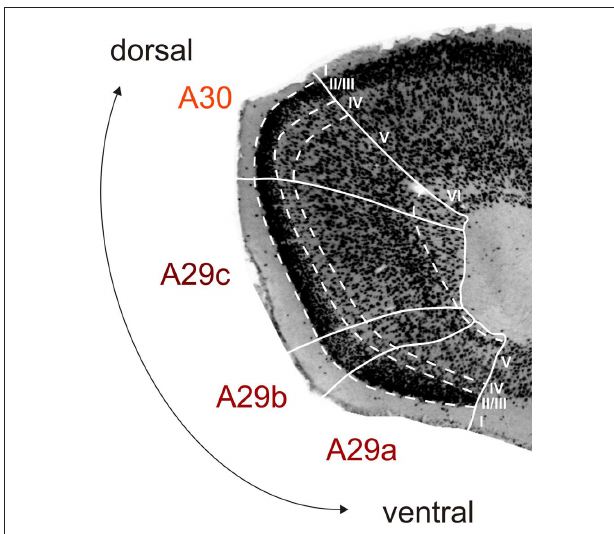
Figure 2 | Cytoarchitecture of rat retrosplenial cortex (rSC). Photomicrograph of a coronal section stained for NeuN (high power image taken from the section shown in Figure 1B2 ), illustrating the cytoarchitectonic characteristics of A29a, A29b, A29c, and A30. A29a has a homogenous layer II/III and lacks fully differentiated deep layers. In A29b layer II/III is divided into a thin superficial densely packed zone and a less dense deeper zone. A29c has a more differentiated layer V and a more equally dense layer II/III compared to A29b and a thinner layer IV compared to A30. A30 shows a widening and a less dense packing of layer II/III and layer V neuronal cell bodies tend to be larger. Layer VI is mostly developed in A30 and A29c and almost absent in A29a and b (for more details see Vogt et al., 2004; Jones et